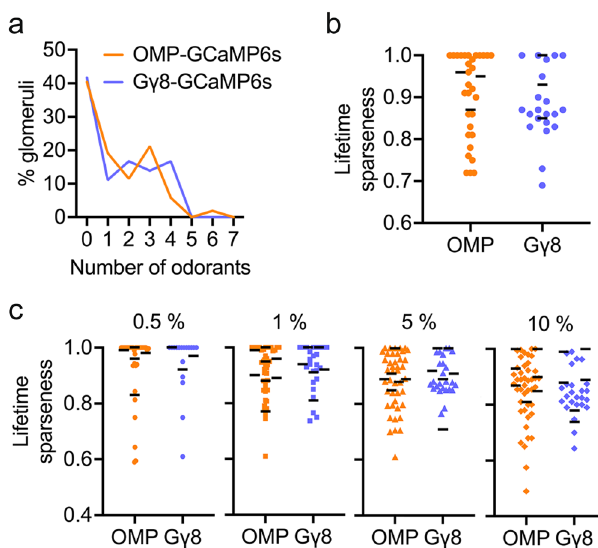
Fig. 6 | Similar odorant selectivity of immature and mature OSN axons across multiple glomeruli and a range of odorant concentrations. a Glomeruli sur- rounding the lateral M72 glomerulus in OMP-GCaMP6s-M72-RFP and G γ 8- GCaMP6s-M72-RFP mice respond to a similar number of odorants in an eight- odorant panel (Wilcoxon signed rank test. P >0.99, W = − 1, n =52 glomeruli from 3 OMP-GCaMP6s-M72-RFP mice and 36 glomeruli from 3G γ 8-GCaMP6s-M72-RFP mice). b Lifetime sparseness of odorant responses of mature and immature OSN axonsinglomerulisurroundingthelateralM72glomerulusissimilar(Nested t -test. P =0.67, t =0.45, n =31odorant-responsiveglomeruliin3OMP-GCaMP6s-M72-RFP mice and 21 odorant-responsive glomeruli in 3G γ 8-GCaMP6s-M72-RFP mice). Lines:meanforeachmouse,symbols:individualglomeruli. c Lifetimesparsenessof odorant responses of mature and immature OSN axons is similar across four dif- ferent odorant concentrations (Nested t -tests. 0.5%: P =0.70, t =0.40, n =71 odorant-responsive glomeruli from 7 OMP-GCaMP6s mice and 30 odorant- responsiveglomerulifrom7G γ 8-GCaMP6smice.1%: P =0.83, t =0.22, n =115odor- responsive glomeruli from 7 OMP-GCaMP6s mice and 61 odorant-responsive glo- meruli from 7G γ 8-GCaMP6s mice. 5%: P =0.95, t =0.060, n =77 odor-responsive glomeruli from 7 OMP-GCaMP6s mice and 81 odorant-responsive glomeruli from 7G γ 8-GCaMP6s mice. 10%: P =0.55, t =0.62, n =138 odorant-responsive glomeruli from 7 OMP-GCaMP6s mice and 85 odorant-responsive glomeruli from 7G γ 8- GCaMP6s mice). Lines: mean for each mouse, symbols: individual glomeruli. All relevant statistical tests were two-tailed. Source data are provided as a Source Data fi